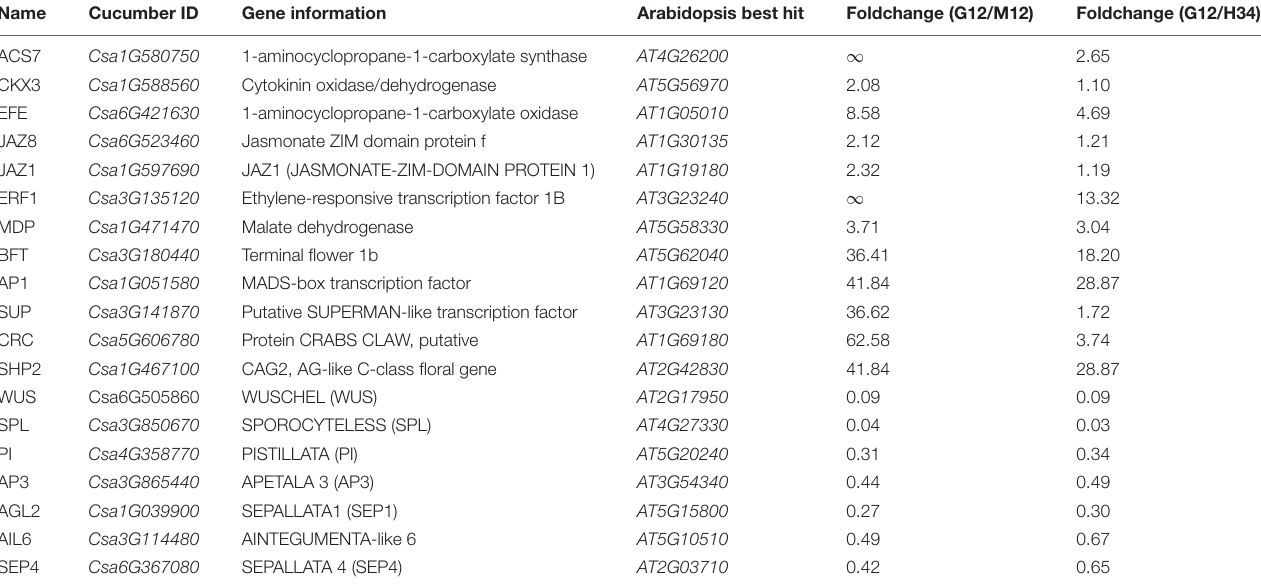
FIGURE 5 | Effects of CsERF31 on the transcriptional activity of M promoter. (A) Schematic diagram of the constructs using Dual-LUC analysis in a tobacco transient expression system. Effector constructs contained the CaMV 35S promoter fused to the transcription factors CsERF31 . Reporter constructs contained 2 or 1 kb of M promoter, upstream of the translation initiation sites, fused to the LUC reporter gene. REN was used as the internal control. (B) Effects of CsERF31 on the activity of 2 kb (two ERE-box in it) or 1 kb (only the near ERE-box in it) of M promoter. Error bars represent the SD from four biological replicates, and different letters (a, b) indicate significant differences ( P < 0.05) of the transcriptional activation activity with different promoter regions. (C) Yeast one-hybrid assay of interaction between CsERF31 and the distant ERE-box (D ERE-box) or the near ERE-box (N ERE-box). (D) Schematic diagram of CsERF31 binding the D ERE-box in M promoter to activate M transcription. TABLE 1 | Information of the genes present in the predicted protein interaction